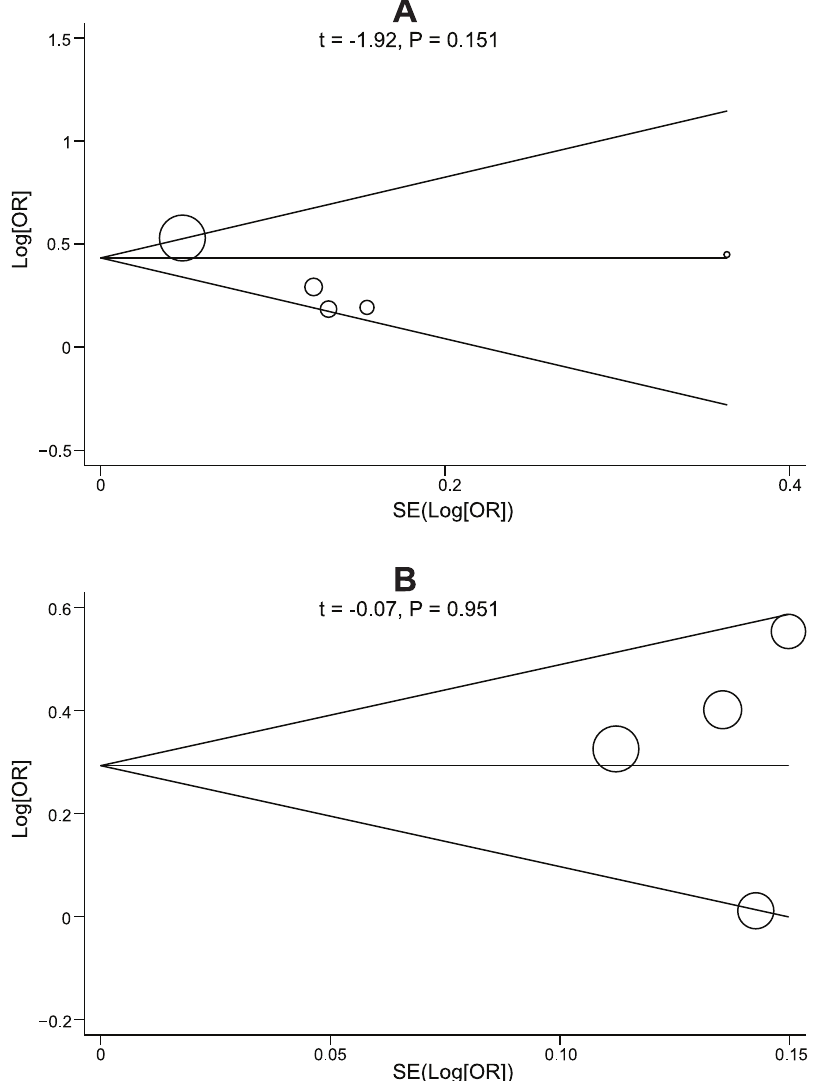
Figure 6. Begger’s funnel plots of the relationships of CETP rs708272 (C . T) and rs1800775 (C . A) polymorphisms with myocardial infarction risk. Each point represents a separate study for the indicated association. Log[OR], natural logarithm of OR. Horizontal line, mean magnitude of the effect.